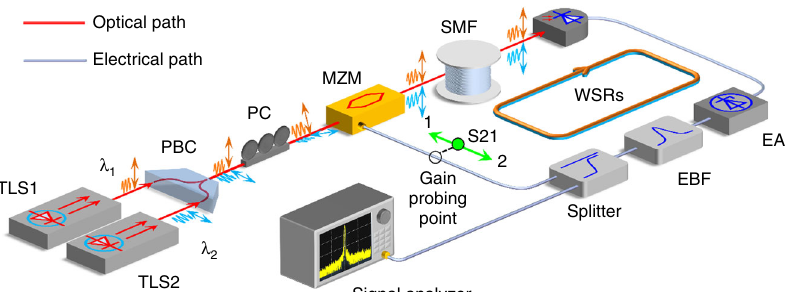
Fig. 2 Experimental implementation of a PT-symmetric OEO in the wavelength space. The system consists of a single optical and electrical hybrid spatial loop, in which two optical carriers of different wavelengths are used to allow the propagation of the microwave eigenmodes through the delay fi ber. TLS tunable laser source; PBC polarizer beam combiner; PC polarization controller; MZM Mach-Zehnder modulator; SMF single-mode fi ber; PD photodetector; EA electrical ampli fi er; EBF electrical bandpass fi lter; WSR wavelength-space resonator.